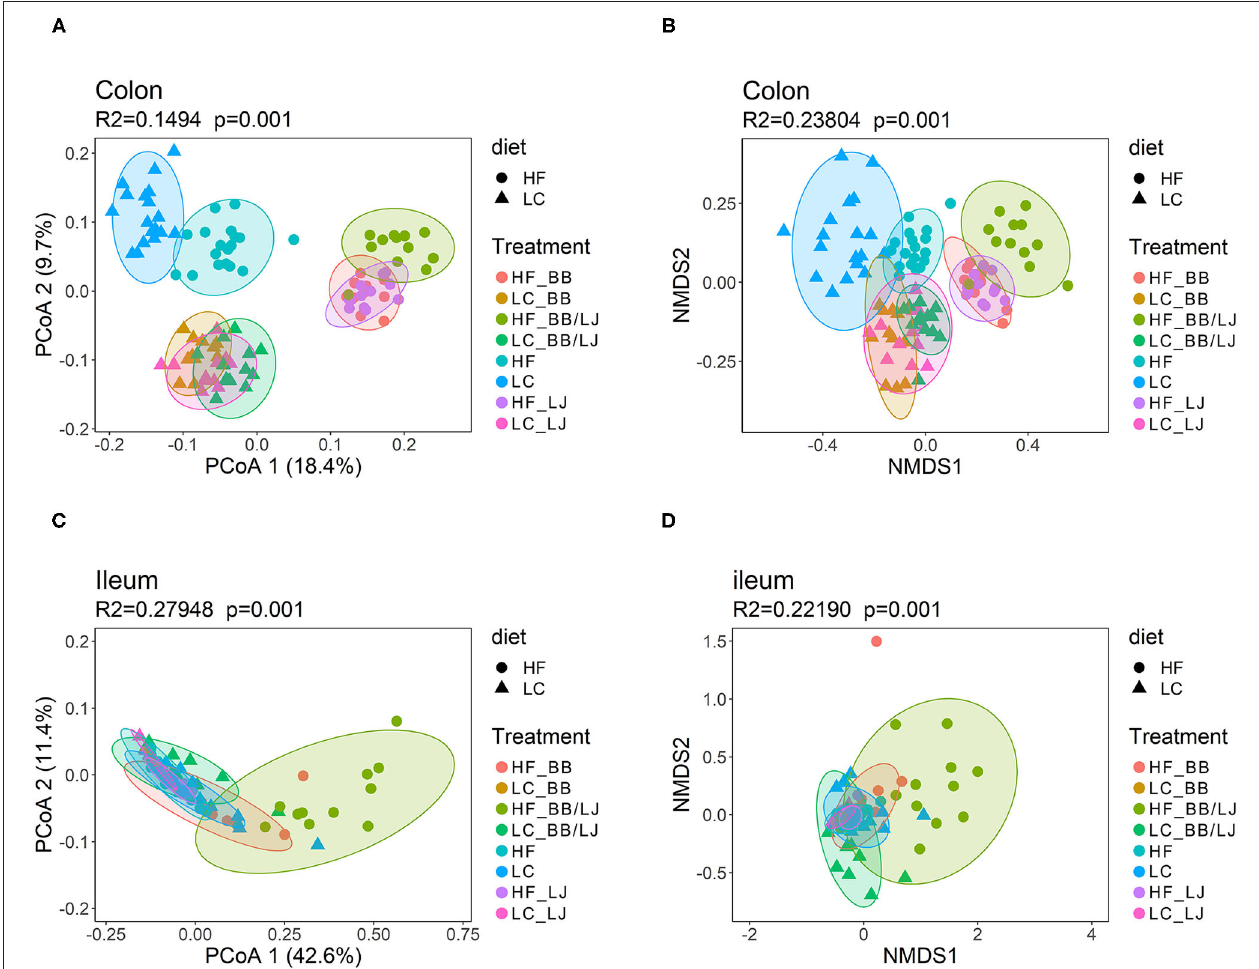
FIGURE 9 | β -diversity analysis using PCoA and NMDS plots. (A) PCoA and (B) NMDS plots showing the cluster distribution of samples collected from colon. (C) PCoA and (D) NMDS plots showing the cluster distribution of samples collected from ileum. PERMANOVA was used to evaluate the statistical significance of the assay.